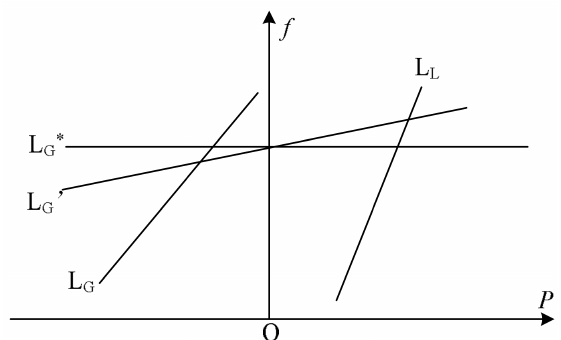
Figure 8. Frequency characteristics comparison of different